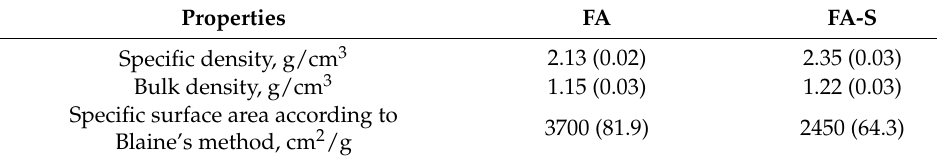
Table 2. Physical properties of the fly ash (FA) and ash–slag (FA-S) mixture.